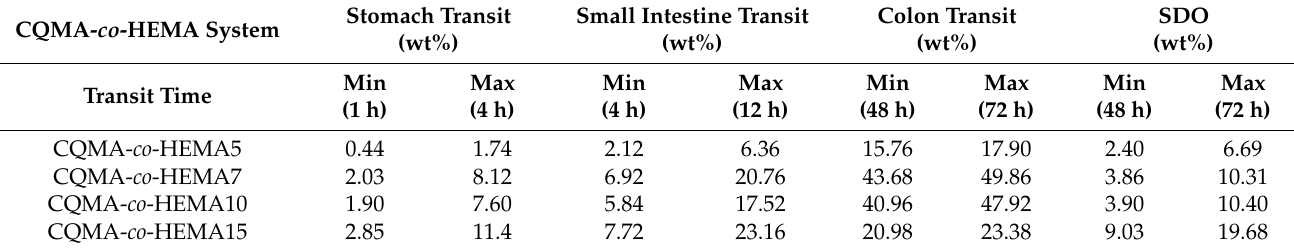
Table 7. Estimated distribution of the cumulative HCQ released from CQMA- co -HEMA drug carrier systems on the principal digestive organs timed according to